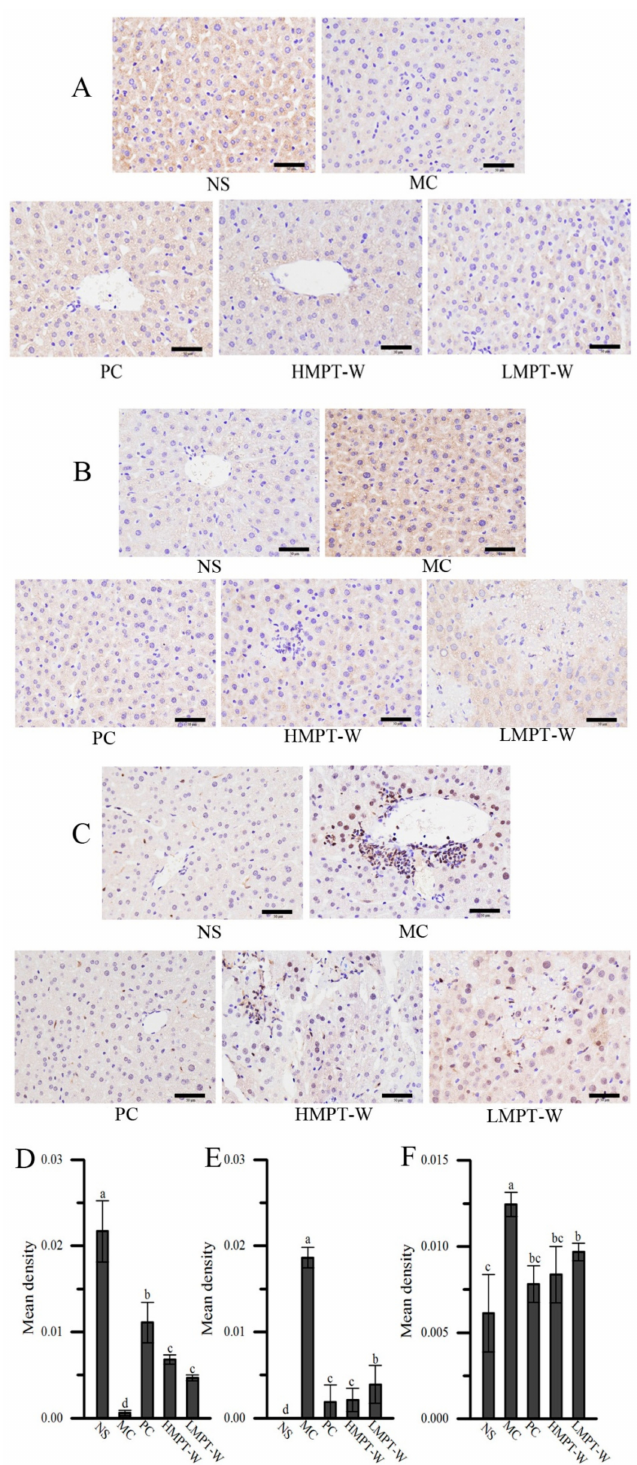
Figure 9. Immunohistochemistry analysis. Immunohistochemistry images of ( A ) I κ B α , ( B ) IKK and ( C ) p-NF- κ B p65; immunohistochemistry quantification of ( D ) I κ B α , ( E ) p-IKK and ( F ) p-NF- κ B p65. The values are reported as means ± SD. Bars with di ff erent letters (a, b, c, d, e) are significantly di ff erent ( p < 0.05). p-NF- κ B: phosphor-nuclear factor-kappa B, I κ B α : NF-kappa-B inhibitor alpha, p-IKK: phosphor-inhibitor of nuclear factor kappa-B kinase alpha /